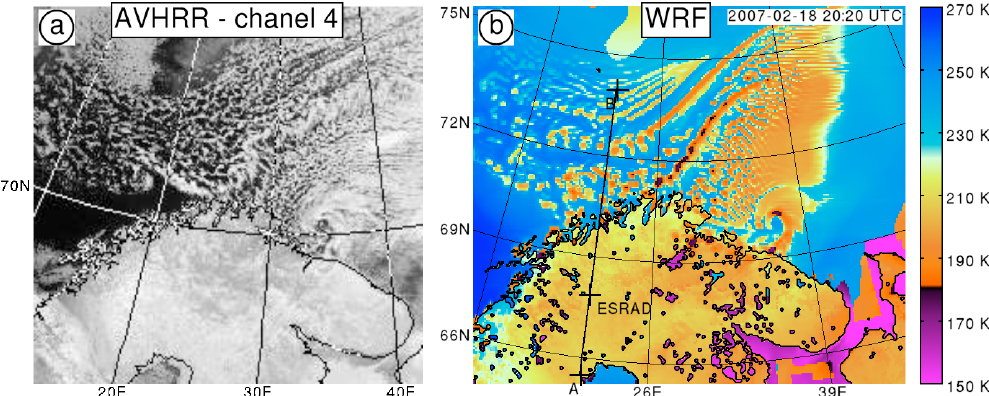
Fig. 2. (a) Advanced Very High Resolution Radiometer (AVHRR) image taken by the polar orbiting NOAA-17 satellite in the thermal infra- red (10.3–11.3µm) channel 4 at 20:14UTC on 8 February 2007 (from http://www.sat.dundee.ac.uk). (b) OLR (K) retrieved from the WRF simulation with clouds and orography at 20:20UTC on 18 February 2007. The brightness temperature scale is given by the coloured bar to the right. The straight black line (A–B) gives the location of the vertical cross sections in Fig. 6. The position of the ESRAD radar is located by a black cross.